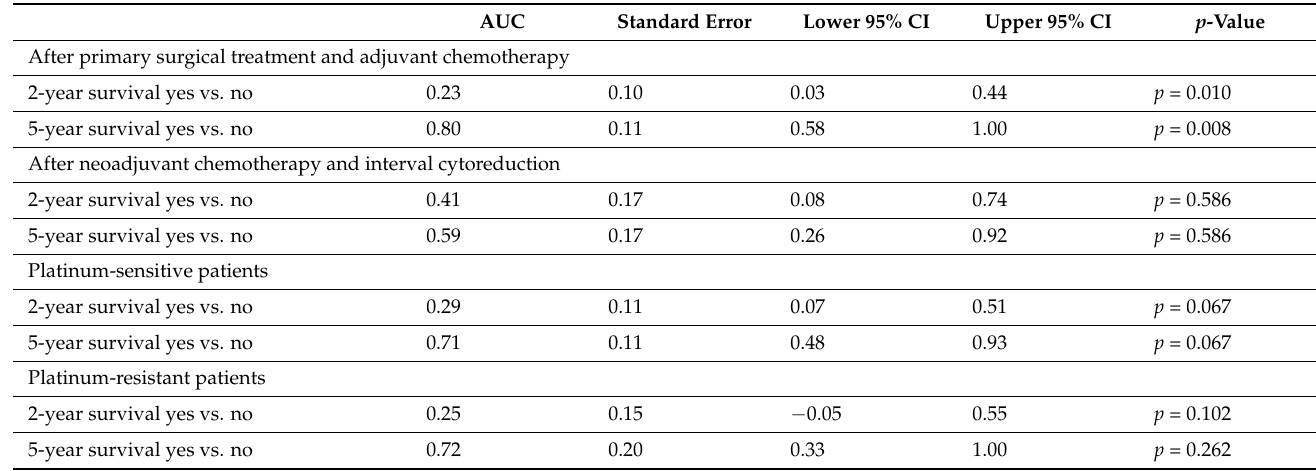
Table A6. Assessment of serum HE4 prognostic value after the last course of third-line